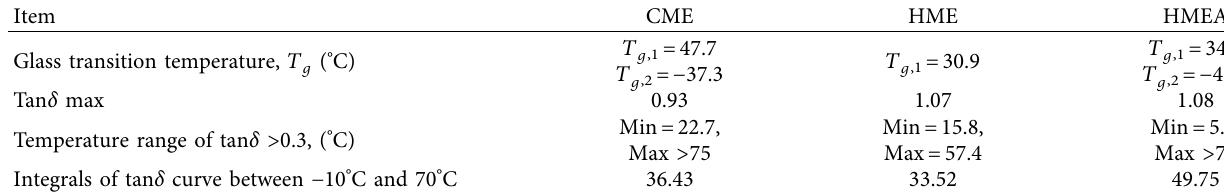
Table 8: Damping behavior of CME, HME, and HMEA determined by DMA.